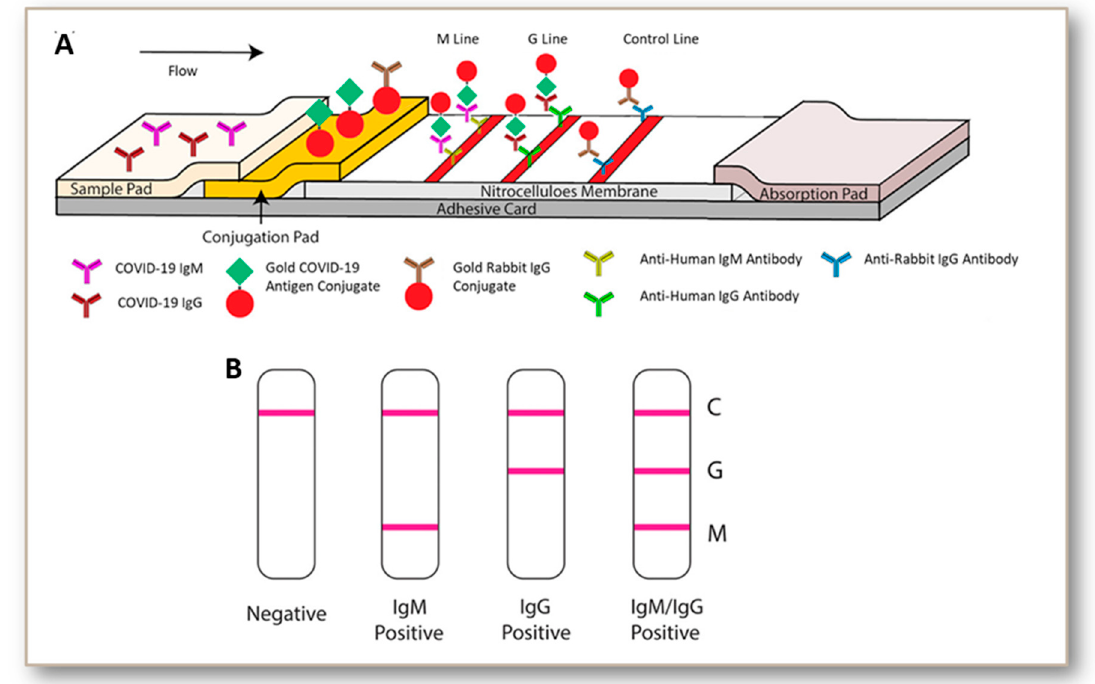
Figure 4. Steps in lateral flow immunoassay (LFIA)-based COVID-19 diagnosis ( A ). LFIA is performed by using the blood sample collected from the individual with suspected COVID-19 suspected infection. Lateral flow tests involve the migration of an antigen or antigen–antibody complexes, through an absorbent pad which is attached at the end of the strip. A liquid sample containing the analyte moves through the various zones of the polymeric strip. The sample pad acts as sponge and once soaked it allows the fluid to pass to the second conjugate pad. The conjugate pad contains all the reagents required to conduct a chemical reaction between antigen and antibody. As the antigen passes through the pad there forms a mark. The antigen continues to pass through the test and control lines. After passing through these lines, the fluid enters to a porous material which serves as a waste container. Depending upon the patient’s condition either negative (only control mark developed), IgM (+) (both IgM and control marks are developed), IgG (+) (both IgG and control marks are developed), or both IgM and IgG (+) (all the marks are developed) results are obtained ( B ). Reproduced from reference [114] with permission from Wiley.